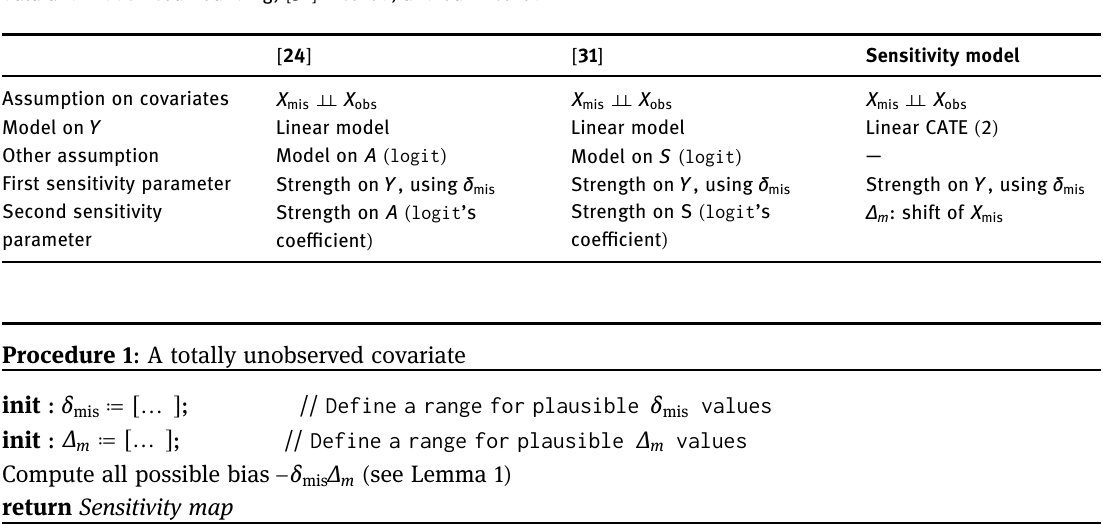
Table 2: Summary of the di ff erences among [ 24 ] method, being a prototypical method for sensitivity analysis for observational data and hidden counfounding, [ 31 ] method, and our